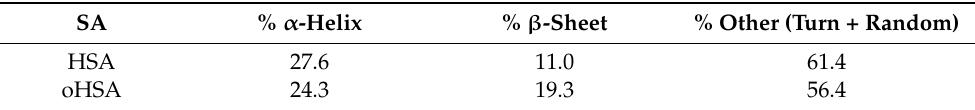
Table 4. The percentage (%) content of the secondary structure elements of HSA and oHSA. Yang’s reference